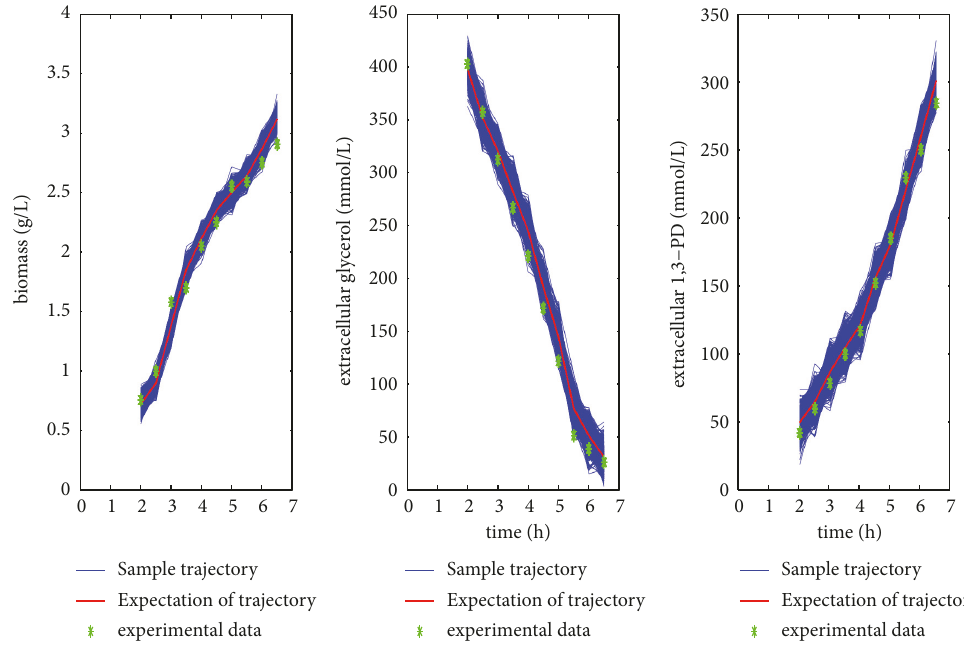
Figure 2: The results of initial glycerol concentration of 441.337 𝑚𝑚𝑜𝑙/𝐿 and biomass concentration of 0.2025 𝑔/𝐿 with 1000 sample